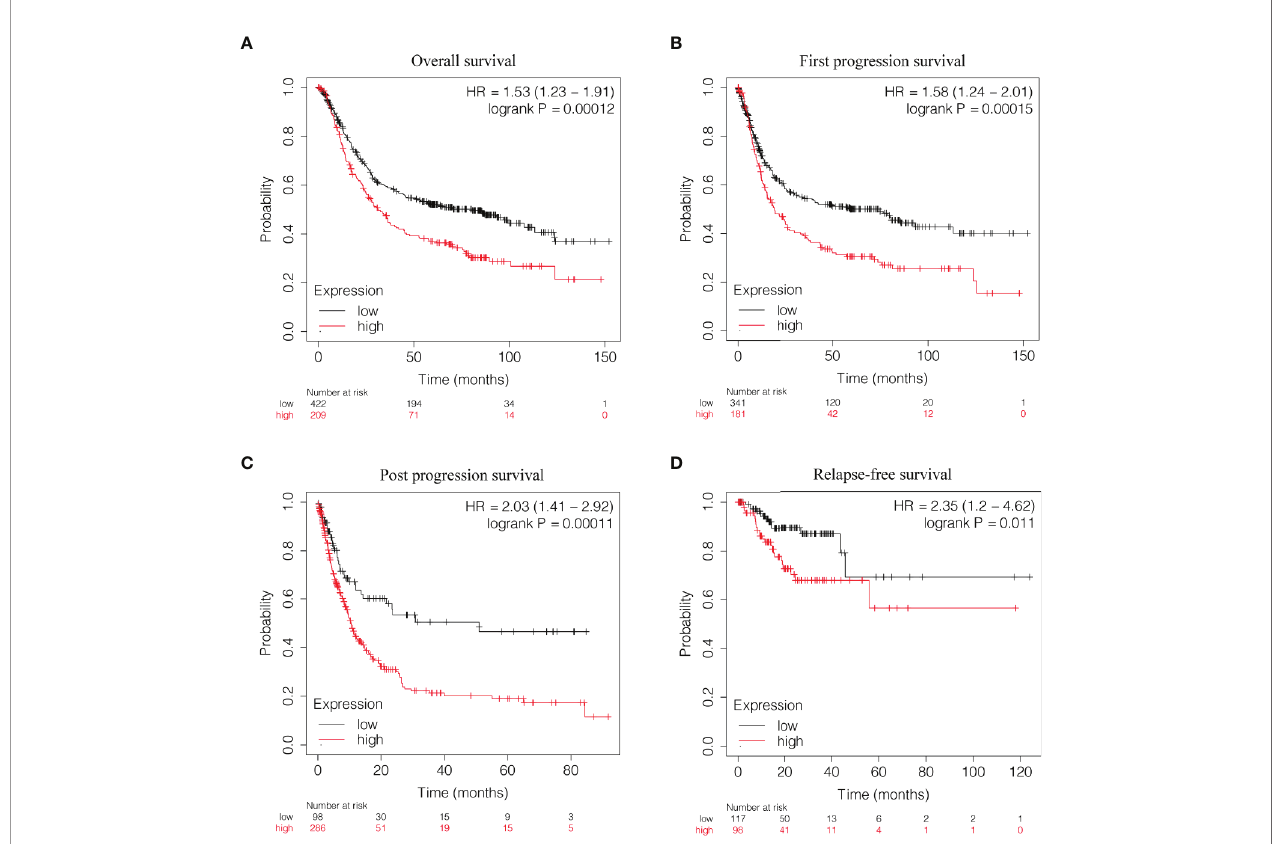
FIGURE 4 | Relationship between GUCY1A2 expression and survival of GC patients based on Kaplan-Meier Plotter database. (A) OS curve of GC patients ( P < 0.001); (B) FP curve of GC patients ( P < 0.001); (C) PPS curve of GC patients ( P < 0.001); (D) RFS curve of GC patients ( P = 0.011). OS, overall survival; FP, fi rst progression survival; PPS, post progression survival; RFS, relapse-free survival.